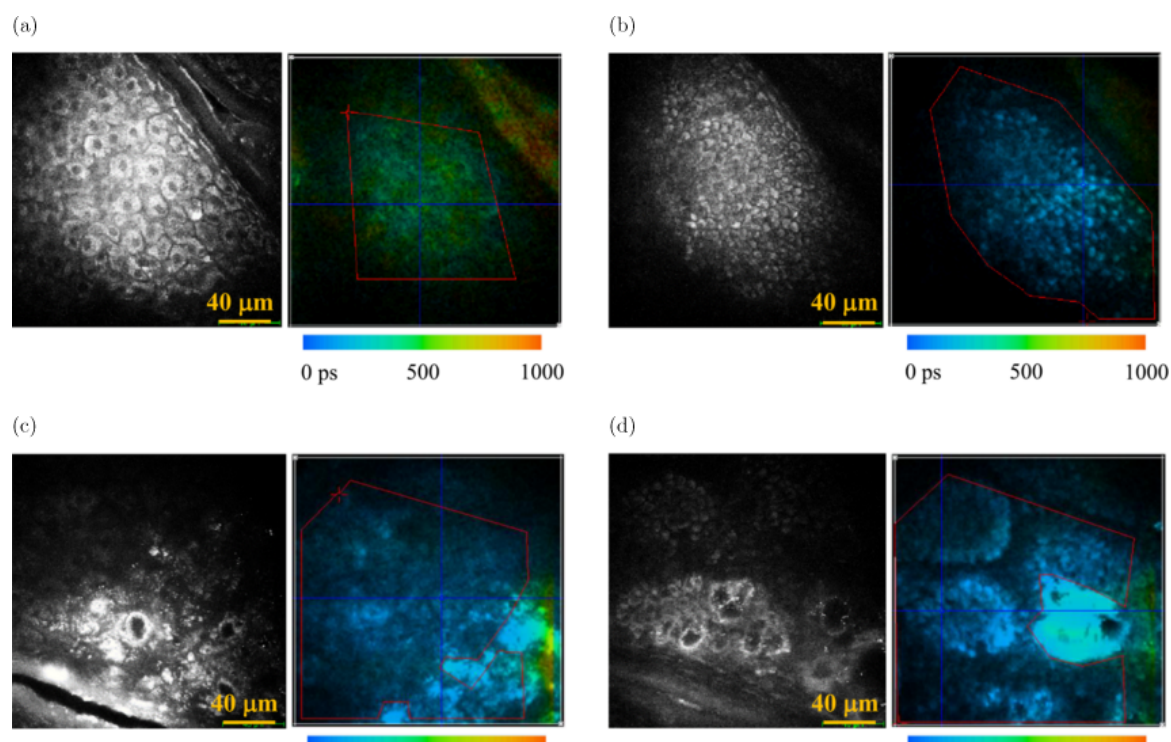
Fig. 5. Fluorescence lifetime imaging of the dorsal and volar forearm. Asian volunteer's (a) stratum granulosum and (b) stratum basale. African volunteer's (c) stratum granulosum and (d) stratum basale. 26 (Permission has been granted by